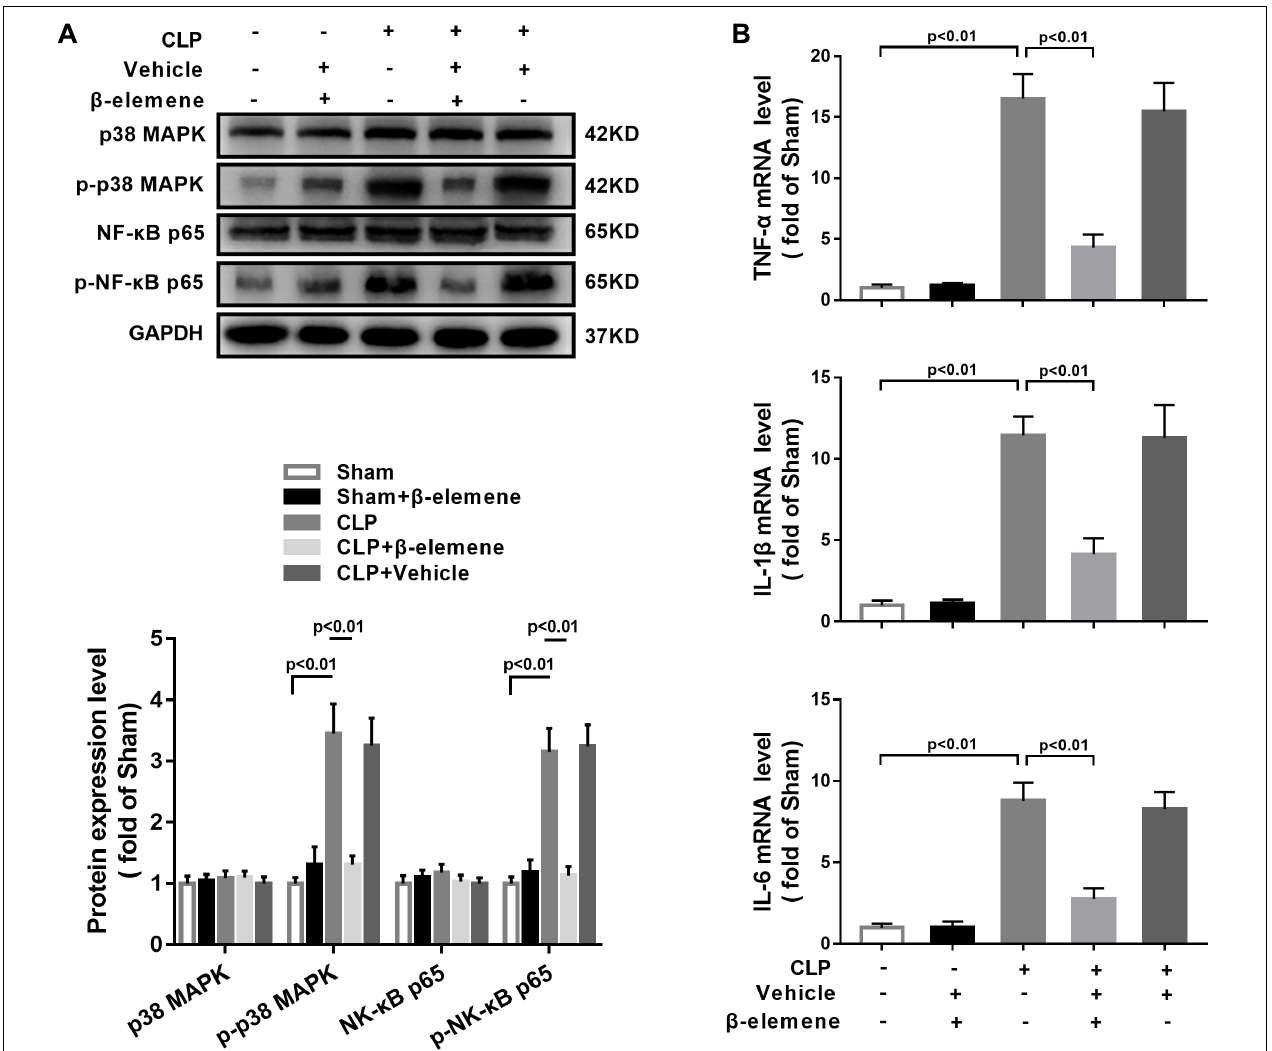
FIGURE 8 | β -Elemene reduced p38 MAPK phosphorylation and expressions of pro-inflammatory cytokines in the hippocampus of CLP mice. (A) Western blotting detected that β -elemene significantly weakened the phosphorylation of p38 [F(4, 15) = 44.95] and p65 [F(4, 15) = 58.7] normalized to that of GAPDH. (B) RT-PCR detected that β -elemene significantly reduced the mRNA expressions of TNF- α [F(4, 15) = 83.98], IL-1 β [F(4, 15) = 64.01] and IL-6 [F(4, 15) = 73.18]. GAPDH was used as a loading control. n = 4. Two-way ANOVA revealed a significant difference at p <